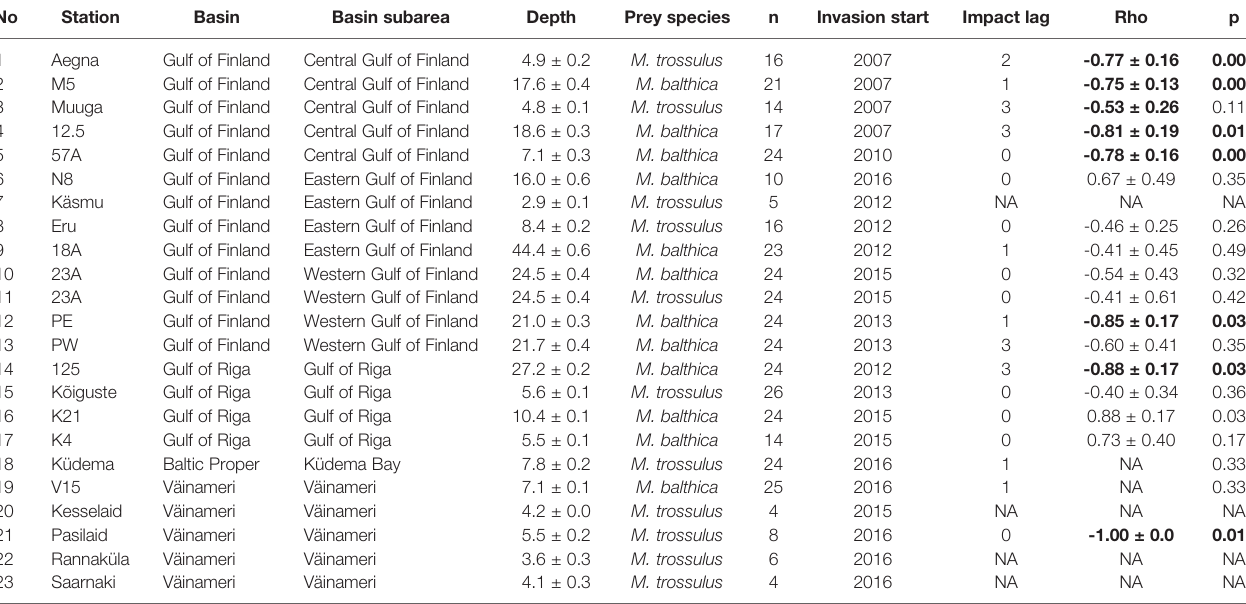
Values marked with bold indicate statistically signi fi cant p-values (<0.05). NA indicates data not available due to insuf fi cient sampling in post-invasion years in